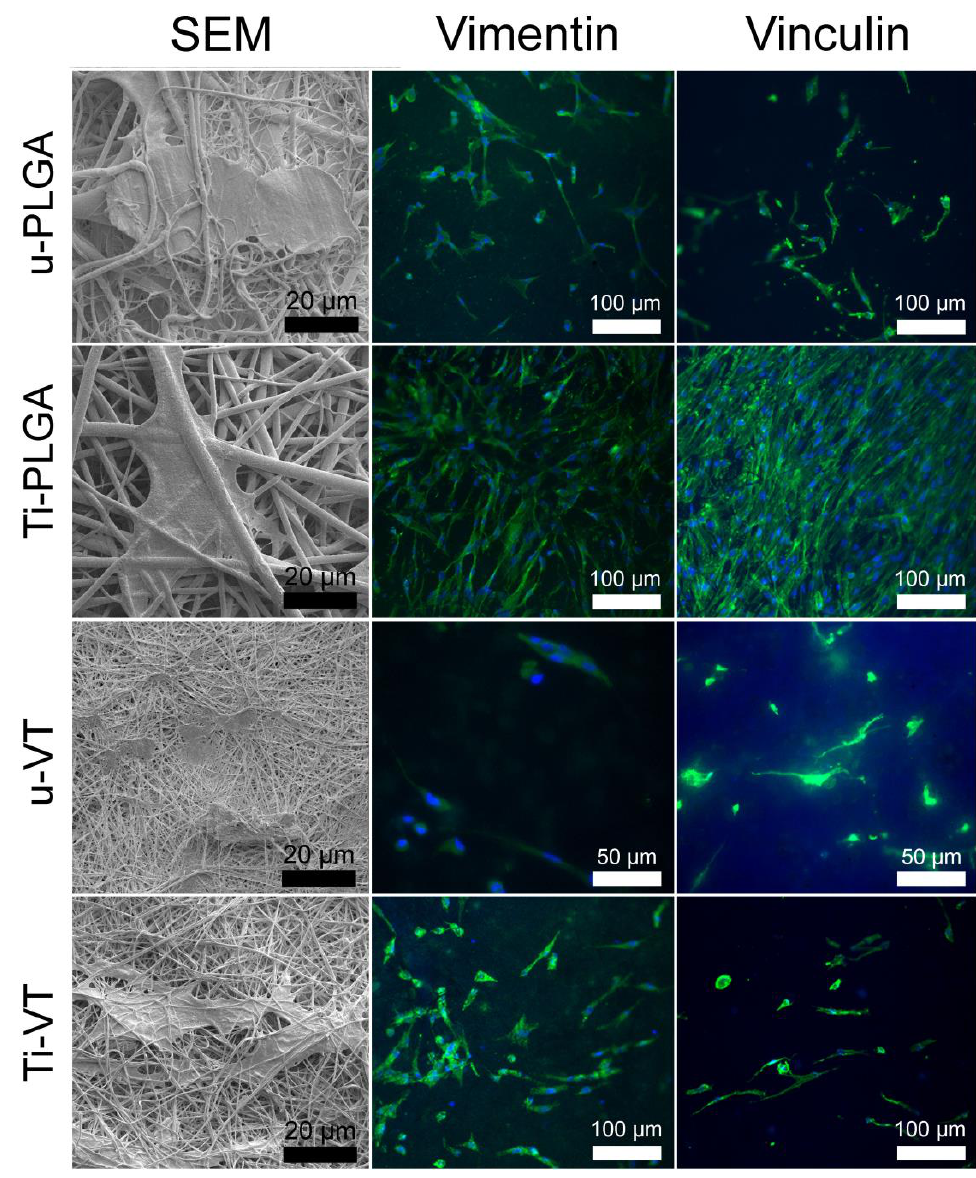
Figure 5. SEM micrographs of human gingival fibroblasts (on the left ) and optical fluorescence micrographs of u-PLGA, u-VDF-TeFE, Ti-PLGA and Ti-VDF-TeFE after 48 h of cell cultivation. Under fluorescent light, the nuclei of the cells appear blue due to staining with DAPI, and the cytoplasm of the cells appears green due to antibody labeling with vimentin (in the middle ) and vinculin (on the right ) and staining with fluorescence dye Alexa488 (see Section 2.2 for more details). The number of gingival fibroblast cells per area on unmodified and surface-modified PLGA and VDF-TeFE scaffolds is shown in Figure 6. As it can be seen, the immunocyto- chemical analysis via fluorescence micrographs shows that the number of adherent cells after 48 h of cultivation on the PLGA scaffold samples is significantly higher than on the VDF-TeFE scaffold samples (Figure 6). Fibroblasts did not form confluent surface cover- age and therefore did not show proper cell settlement on VDF-TeFE scaffolds. In contrast, the PLGA scaffolds are better suited for cell adhesion. The surface modification by tita- nium of the PLGA and VDF-TeFE scaffolds results in a significant increase in the cell num- bers compared to the unmodified counterparts of these scaffolds. Forty-eight hours after